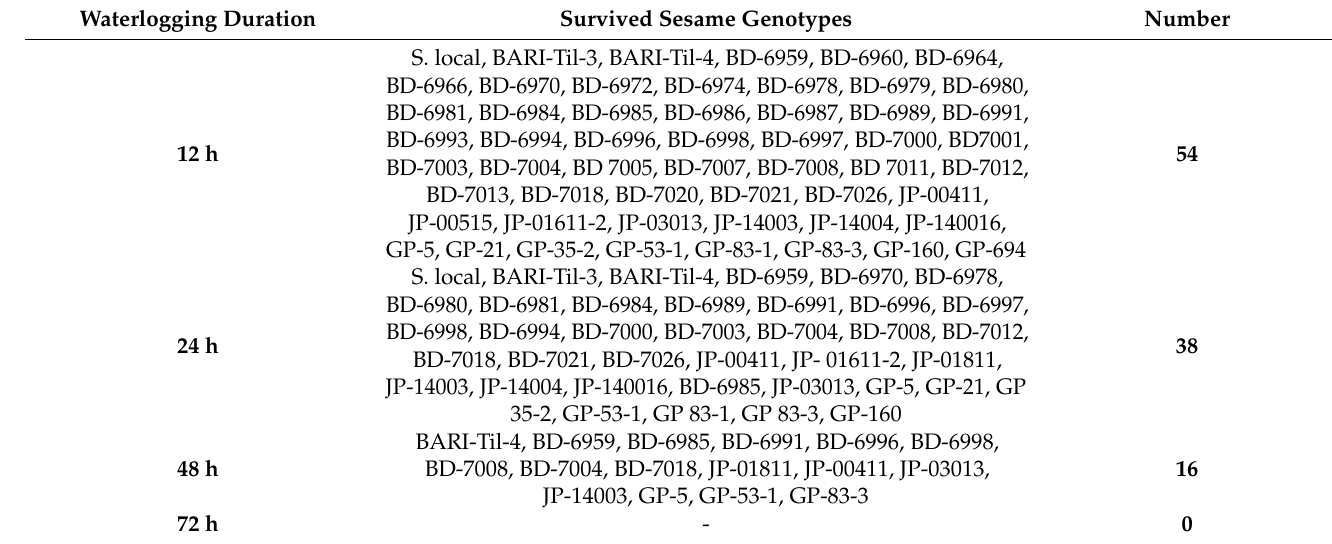
Table 3. List of sesame genotypes that survived under varying durations of waterlogged conditions at the seedling stage. Waterlogging